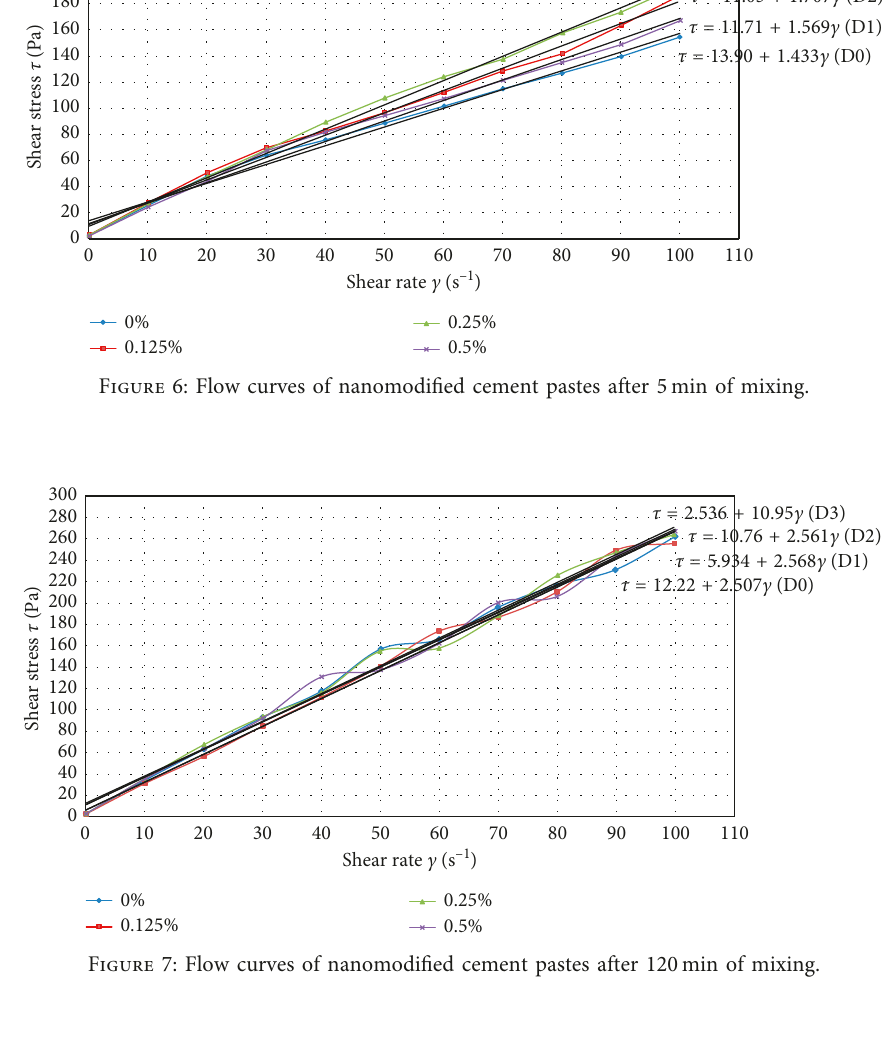
Table 5: Values of plastic viscosity and yield stress for nanomodified cement pastes. After 5min After 120min Dosage of MWCNT dispersion (%) Yield stress (Pa) Plastic viscosity, (Pa · s) Yield stress (Pa) Plastic viscosity (Pa · s)